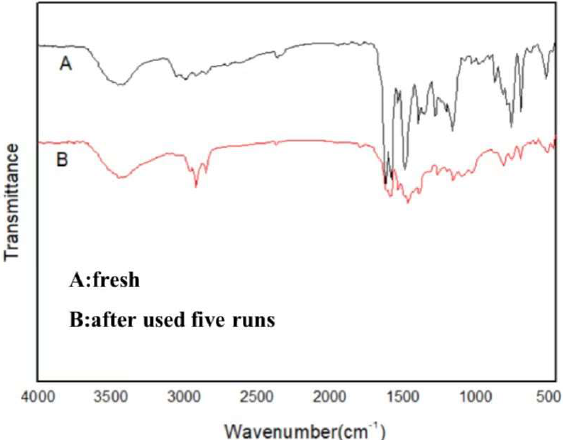
Figure 4. The FT − IR spectra of fresh catalyst and that used after five Figure 4 . The FT−IR spectra of fresh catalyst and that used after five runs.